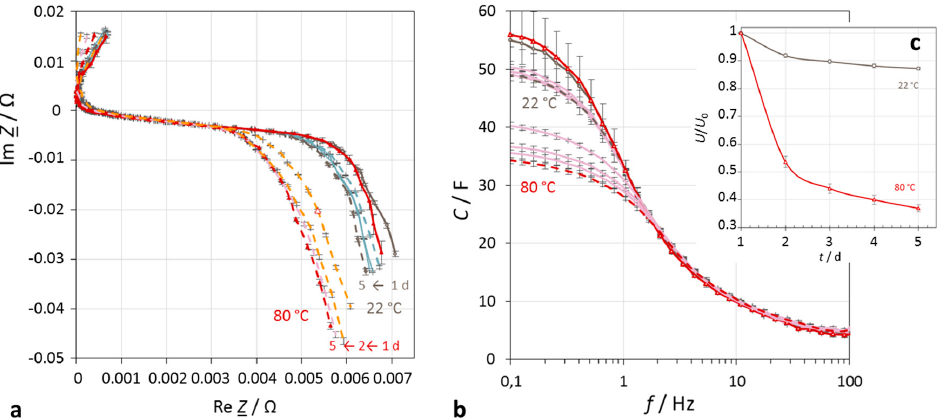
Figure 4. Impact of temperature on the self-discharge of a supercapacitor (Vina Hy-Cap 3 V, 50 F) in the course of five days. ( a ) Impedance spectra in the complex plane at 22 °C and 80 °C ambient temperature, mathematical convention; ( b ) frequency response of capacitance; ( c )